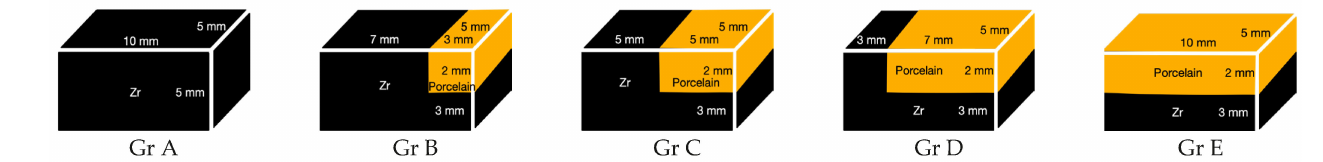
Figure 2. Representative images of all